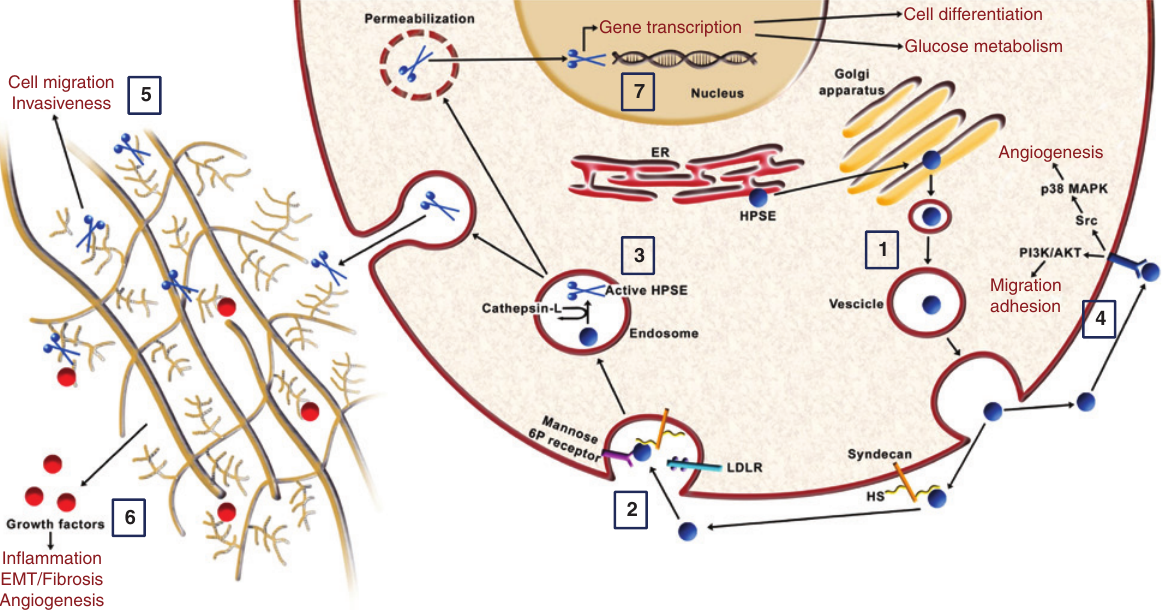
Figure 1: HPSE: processing, localization, enzymatic and non-enzymatic activities. HPSE is synthesized in the endoplasmic reticulum as a latent precursor (pro-HPSE). After moving to the Golgi apparatus, pro-HPSE is secreted outside the cell [1]. HPSE uptake [mediated by syndecans, mannose-6-phosphate-receptor and low-density lipoprotein receptor (LDLR)-related protein] [2], and its delivery to lysosome enables the proteolytic processing (by cathepsin-L) and activation of the precur- sor into the dimeric active enzyme [3]. The interaction of latent HPSE with HPSE-binding proteins activates various intracellular signaling pathways implicated in angiogenesis, cell adhesion and migration [4]. HPSE secretion or translocation into the nucleus may occur under the effect of different stimuli. Extracellular HSPGs degradation encourages cell migration, thus enhancing tumor cell invasiveness and metas- tasis [5]. Angiogenesis, EMT and inflammatory response are indirectly regulated by HPSE via HS-linked growth factors that are released after HS cleavage [6]. Nuclear HPSE translocation is implicated in cell differentiation, inflammation and glucose metabolism through gene transcription regulation mechanisms